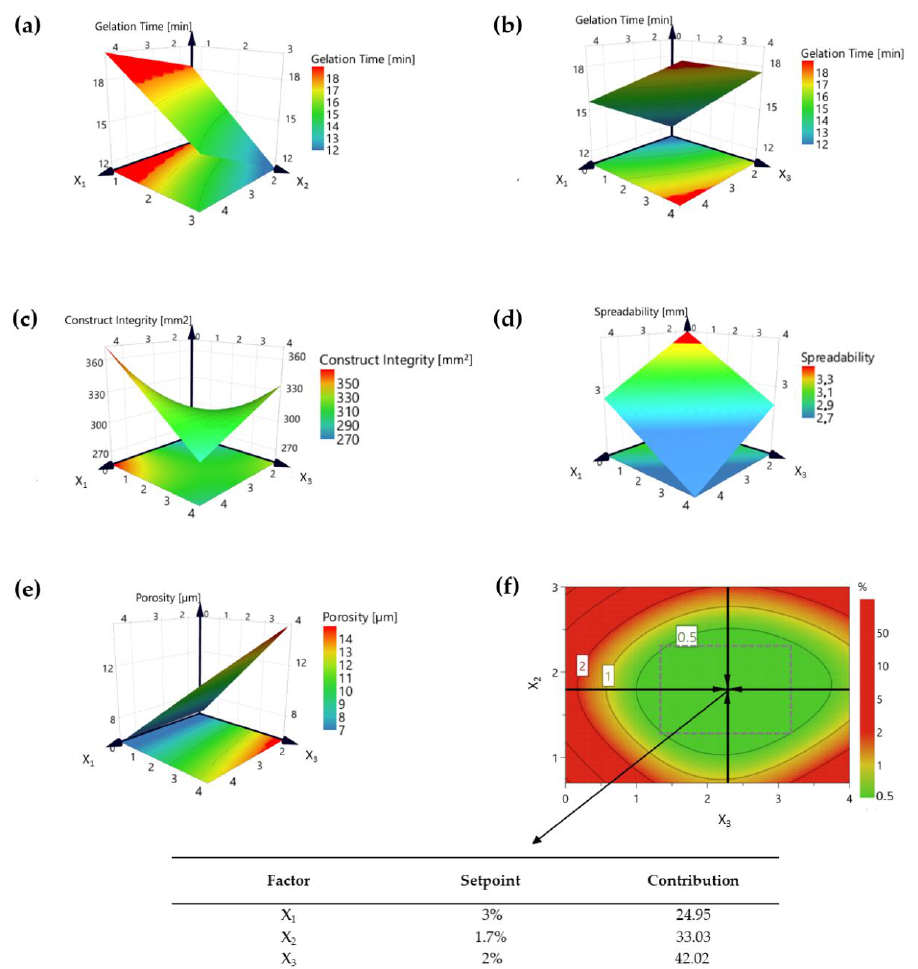
Figure 3. Response contour plots of the fitted model for gelation time ( a , b ), construct integrity ( c ), spreadability ( d ), porosity ( e ), and design space ( f ). spreadability ( d ), porosity ( e ), and design space ( f